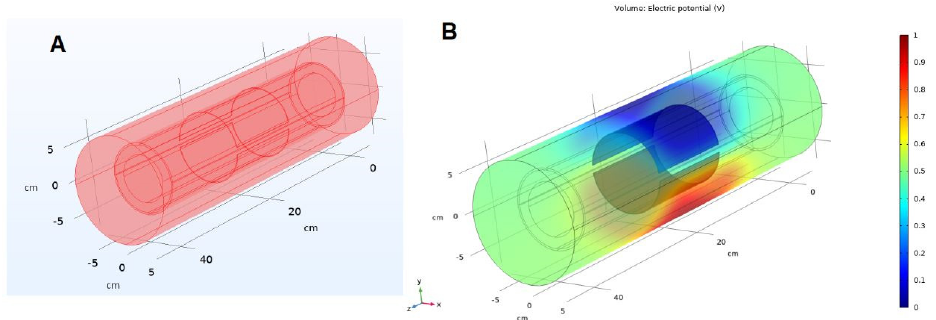
Figure 2. ( A ) The structure schematic used for validating the COMSOL simulation. ( B ) Electric potential distribution of simulated structure of capacitance sensor [31].